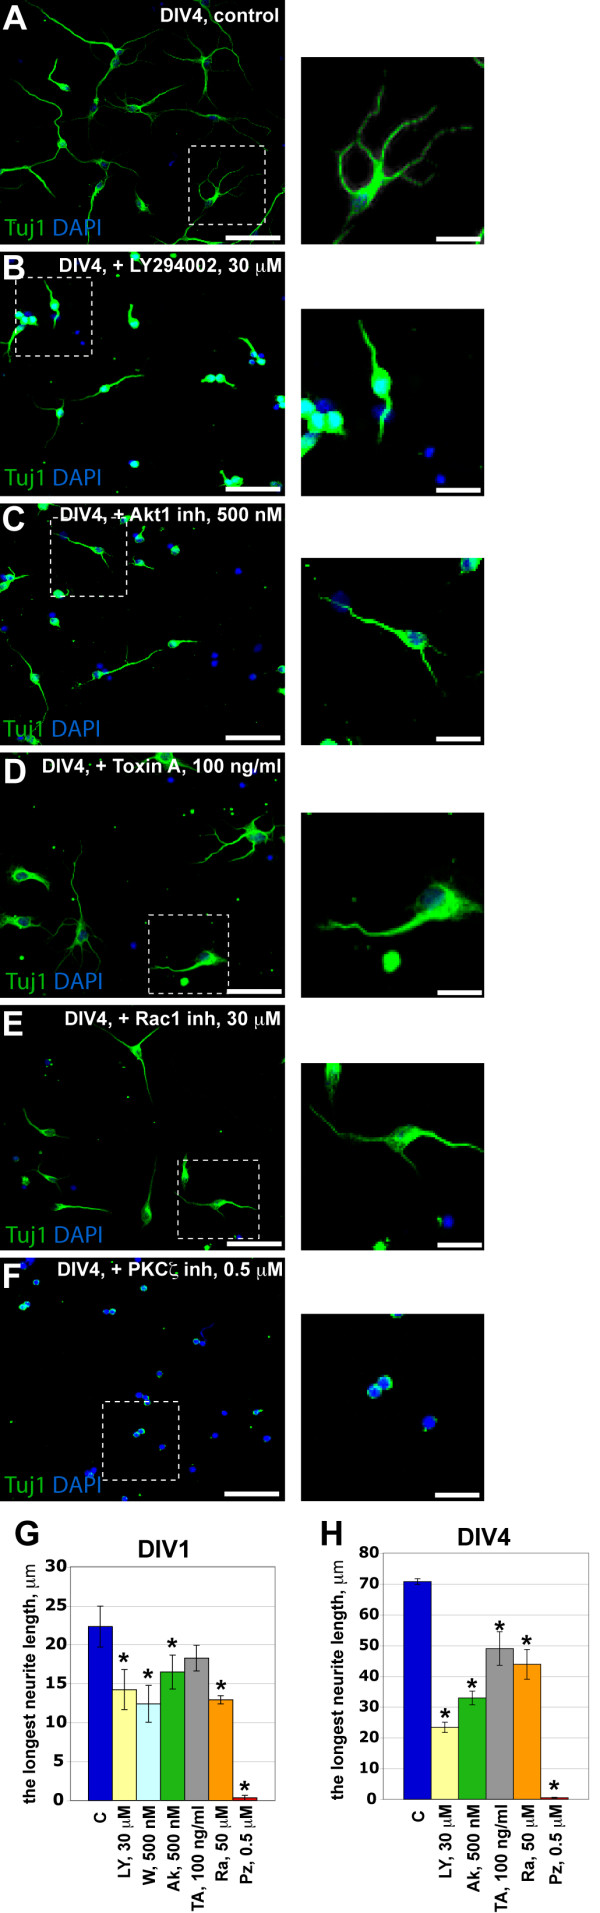
Neurite outgrowth analysis of SVZ/RMS-derived neurons using pharmacological treatments. (A) - (F) Examples of neurite outgrowth analysis in SVZ/RMS cultures treated by DMSO (A), PI3K inhibitor LY294002 (B), Akt1 inhibitor X (C), Toxin A of C. difficile (D), Rac1 inhibitor (E) and PKCζ pseudosubstrate inhibitor myristoylated (F) are shown. (G) and (H) All inhibitors decreased the longest neurite length of the Tuj1-positive cells at DIV1 and DIV4, respectively. (G), * - p < 0.05; (H), * - p < 0.001. Abbreviations: Ak - Akt1 inhibitor, C - control, LY - PI3K inhibitor LY294002, PZ - PKCζ inhibitor, Ra - Rac1 inhibitor, TA - Rho GTPases inhibitor Toxin A of C. difficile, Tuj1 - tubulin beta III to label immature neurons, W - PI3K inhibitor wortmannin. Scale bars in main illustrations are 50 μm and 20 μm in insets.